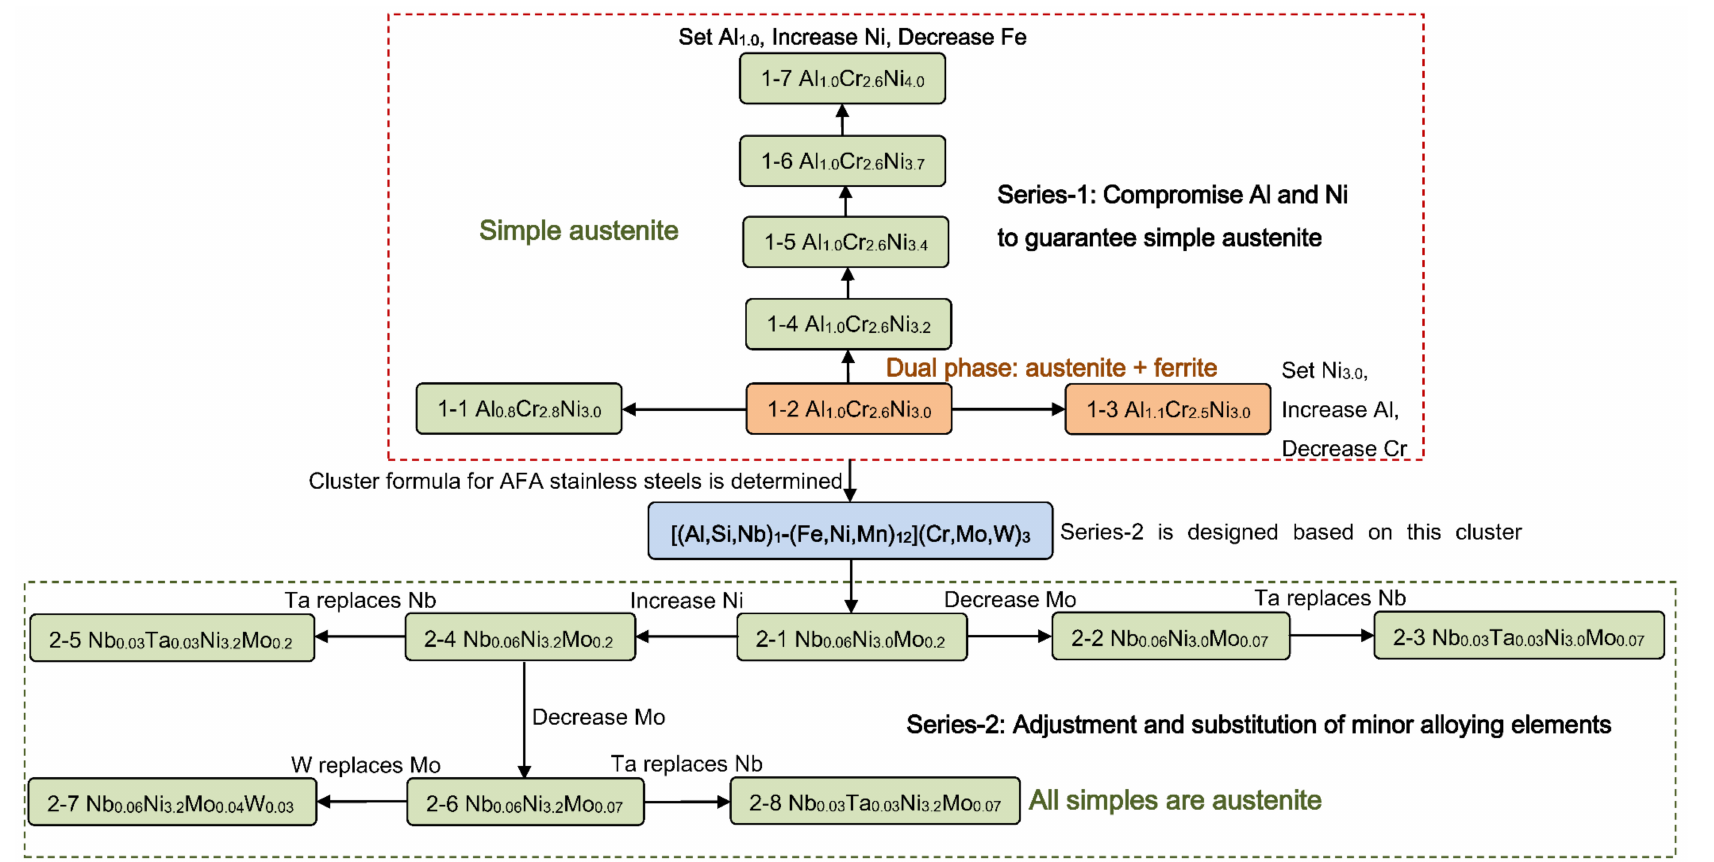
Figure 1. The composition design flowchart of alumina-forming austenitic (AFA) stainless steels based on the cluster-plus-glue-atom